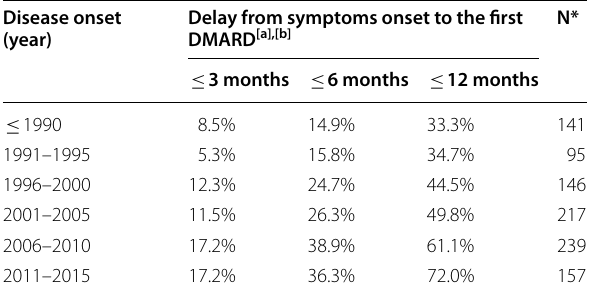
Table 2 Frequency of early RA treatment in Brazil according